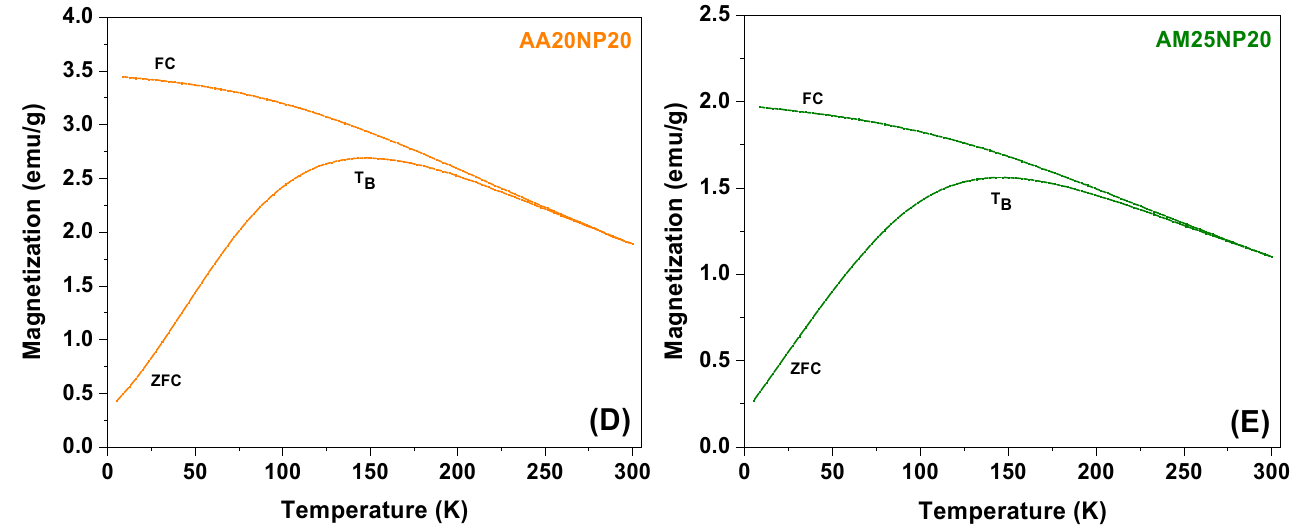
Figure 6. FC/ZFC of ( A ) non-modified Fe 3 O 4 ; ( B ) surface-modified Fe 3 O 4 with acrylic acid; ( C ) surface-modified Fe 3 O 4 with methacrylic acid; ( D ) magnetic poly(vinyl pivalate) containing Fe 3 O 4 modified with acrylic acid (AA20NP20); ( E ) magnetic poly(vinyl pivalate) containing Fe 3 O 4 modified with methacrylic acid (AM25NP20).